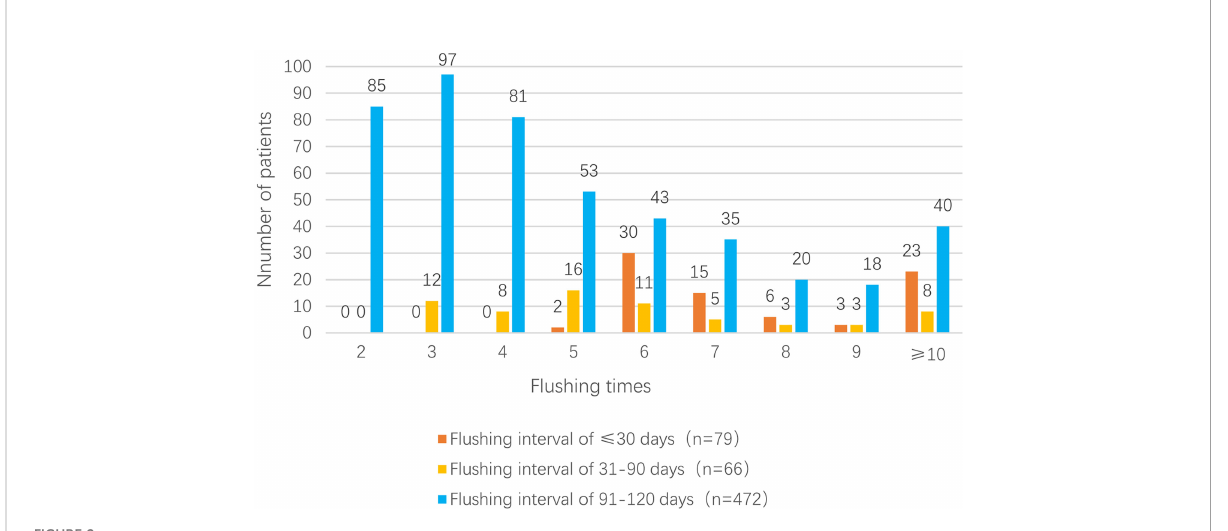
FIGURE 2 TIVAP fl ushing interval in the three groups of